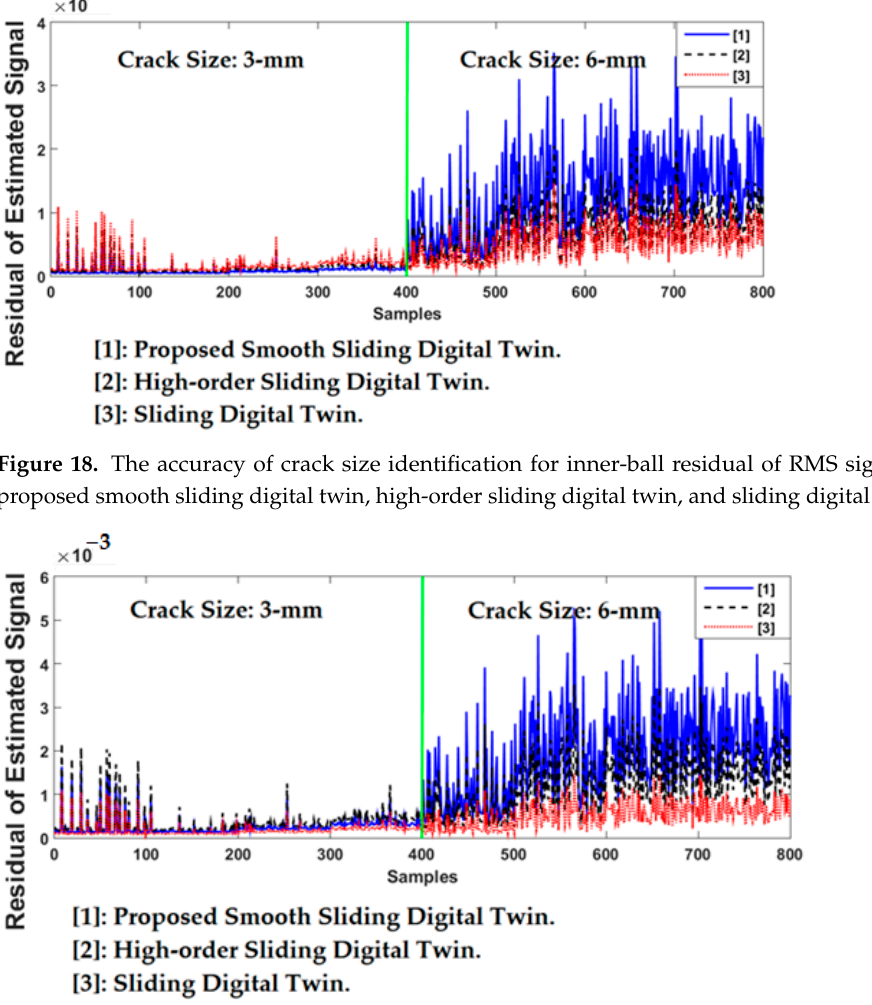
Figure 19. The accuracy of crack size identification for outer-ball residual of RMS signals using proposed smooth sliding digital twin, high-order sliding digital twin, and sliding digital twin.